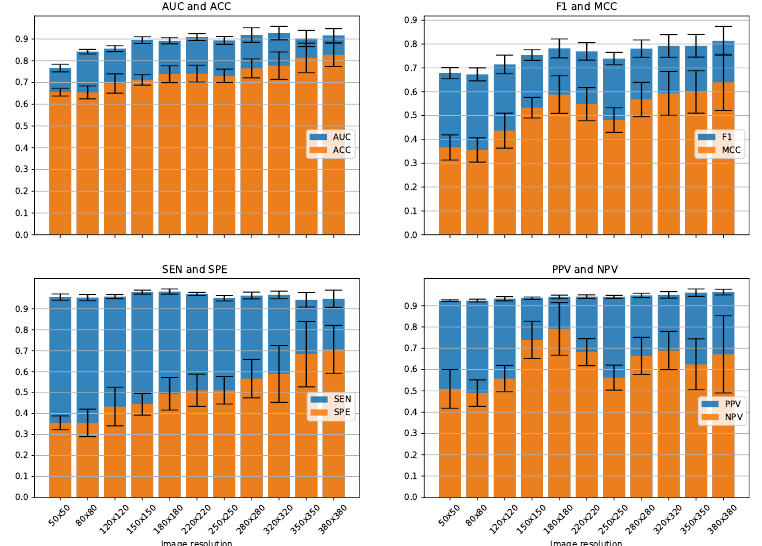
Figure 5. 12-fold cross-validation performance for creating images of various